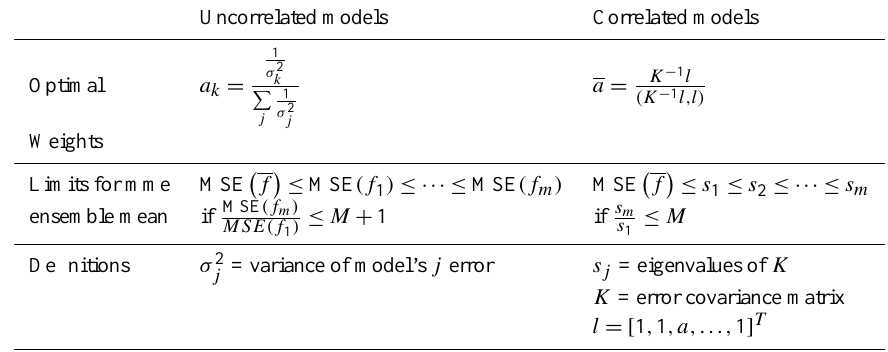
Table 2. Analytical formulas for the 1-D (single-point optimization) case (from Potempski and Galmarini, 2009). Uncorrelated